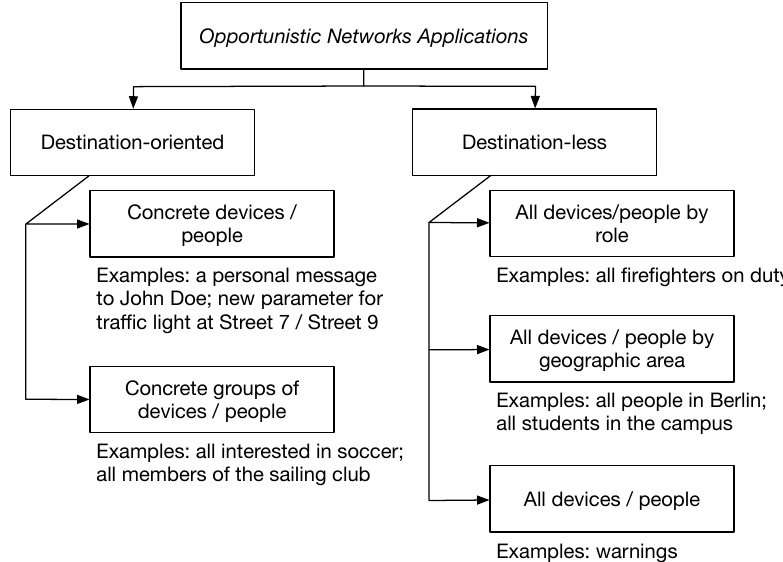
Figure 1. Taxonomy of OppNets Applications in terms of the destination of